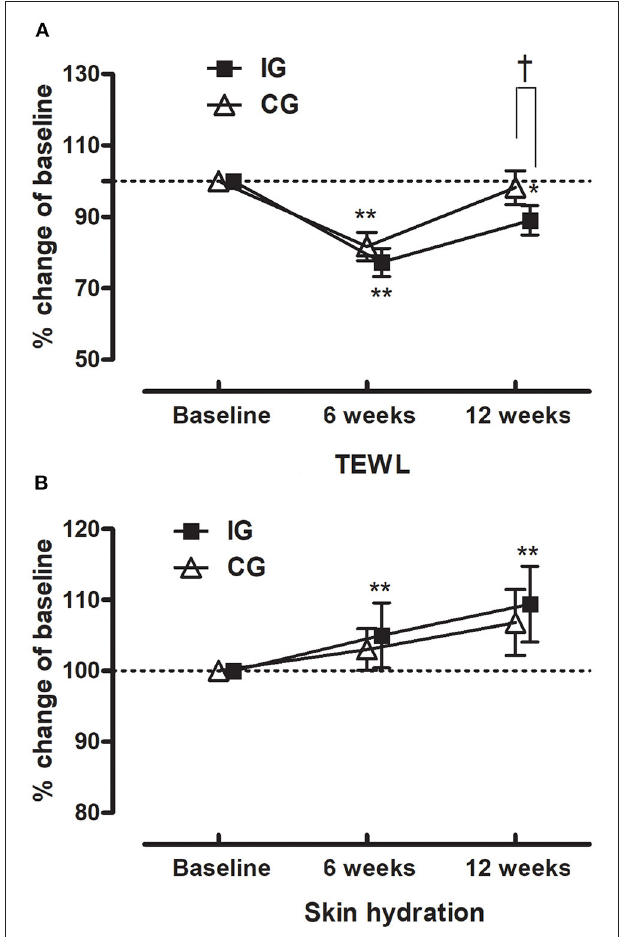
FIGURE 2 | Changes in skin parameters in individuals receiving collagen tripeptide or placebo. (A) Changes in transepidermal water loss (TEWL). (B) Changes in skin hydration. * P < 0.05, ** P < 0.01 by paired t -test comparisons † P < with baseline values. 0.05 by two-sample t -test comparisons between values in the intervention group and the control